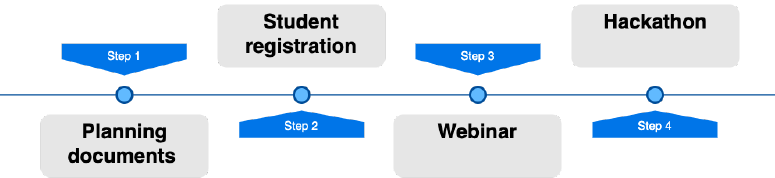
Figure 4: Preparation activities before the